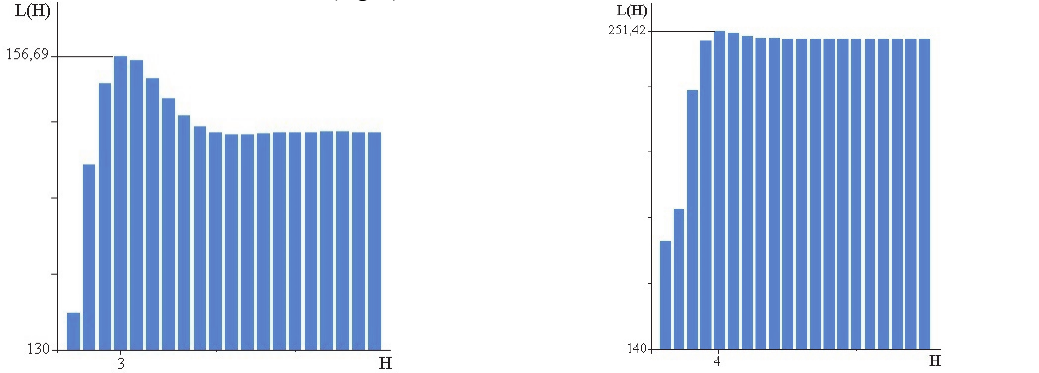
Fig. 2. Dependency curve of the quality functional on the control strategy for the |M Q /M/2/ ꝏ | -